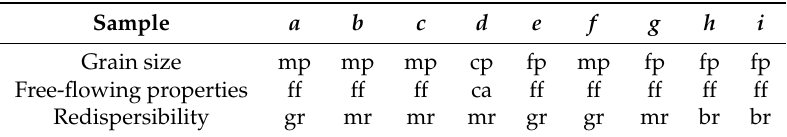
Table 2. Results of the visual analysis of the spray dried polymer latexes. Qualitative grain sizes range from fine (fp) over medium (mp) to coarse (cp) powder. The samples are also classified in free-flowing (ff) and caking (ca) powders. Their redispersibility in water ranges from good (gr), to medium (mr) and to bad (br).